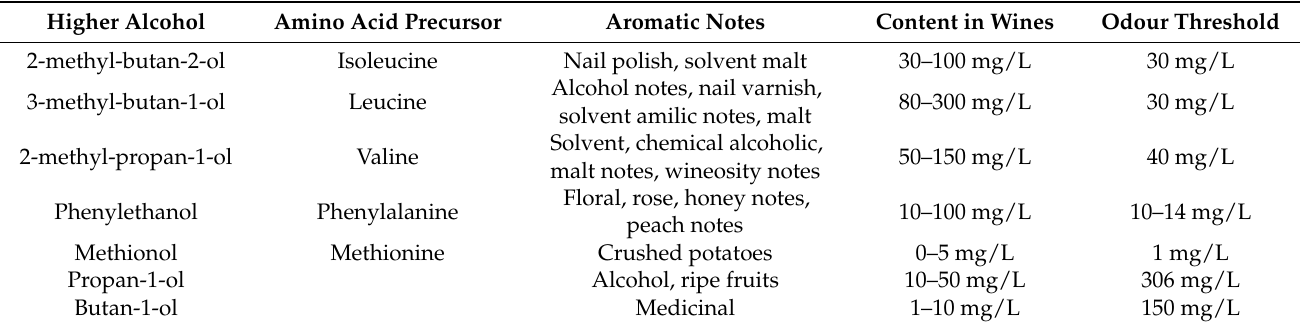
Table 1. Higher alcohols and their precursors in wine